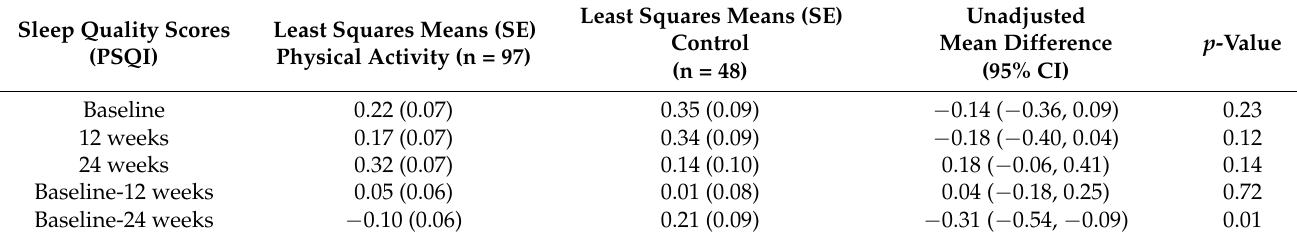
Table A7. Medication Use Component.